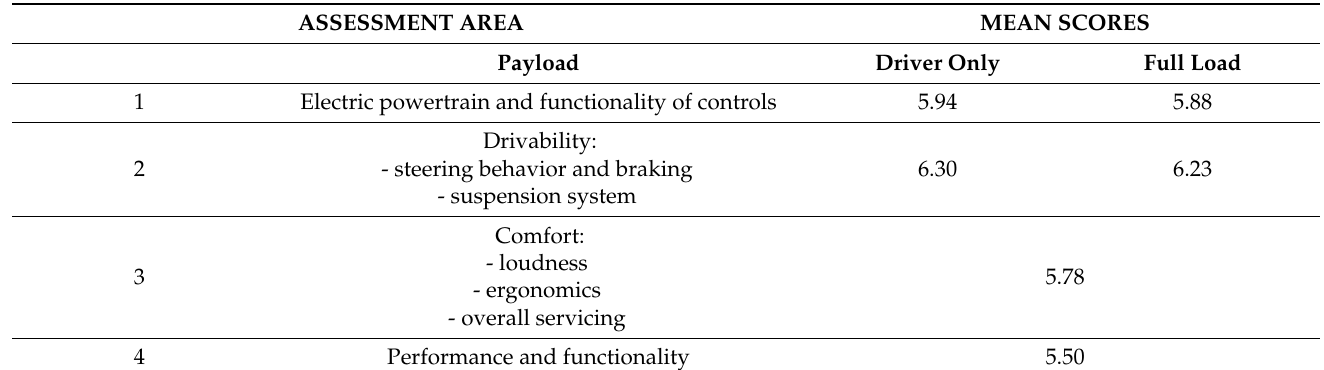
Table 7. Subjective vehicle’s assessment during the on-road test run.